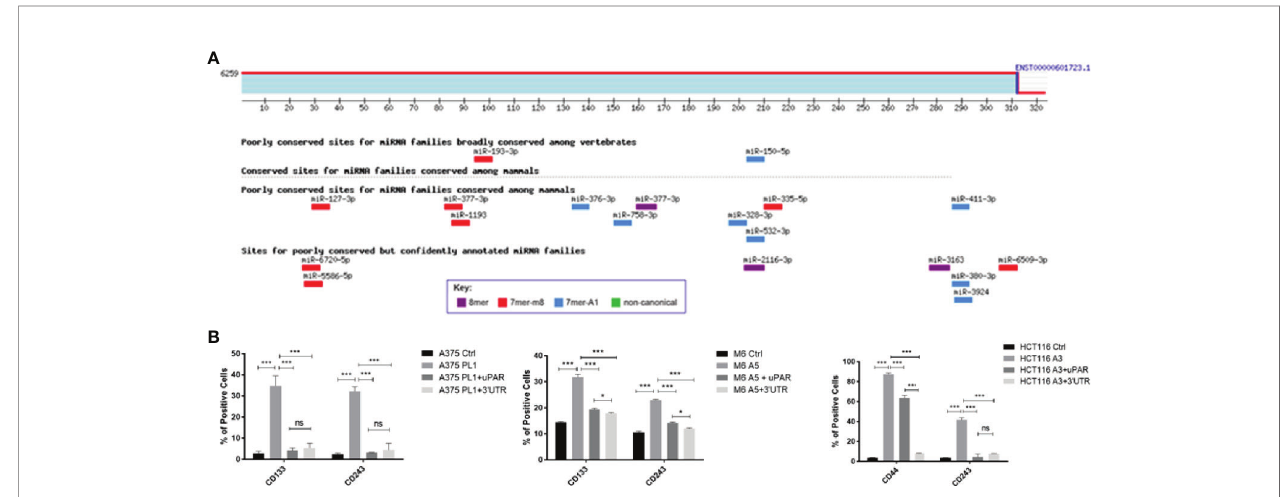
FIGURE 4 | (A) PLAUR 3 ’ UTR was subjected to bioinformatical analysis via TargetScan software, to identify probable interacting miRNAs candidates and their binding sites. (B) uPAR KO cells were tested for CD133 while colon carcinoma uPAR KO cells were tested for CD44 by FACS analysis. CD243 expression was evaluated on all the three uPAR KO cell lines (n = 3). Values are mean ± SD; *p <0.01, ***p <0.0001, ns, not signi fi cant (One-Way